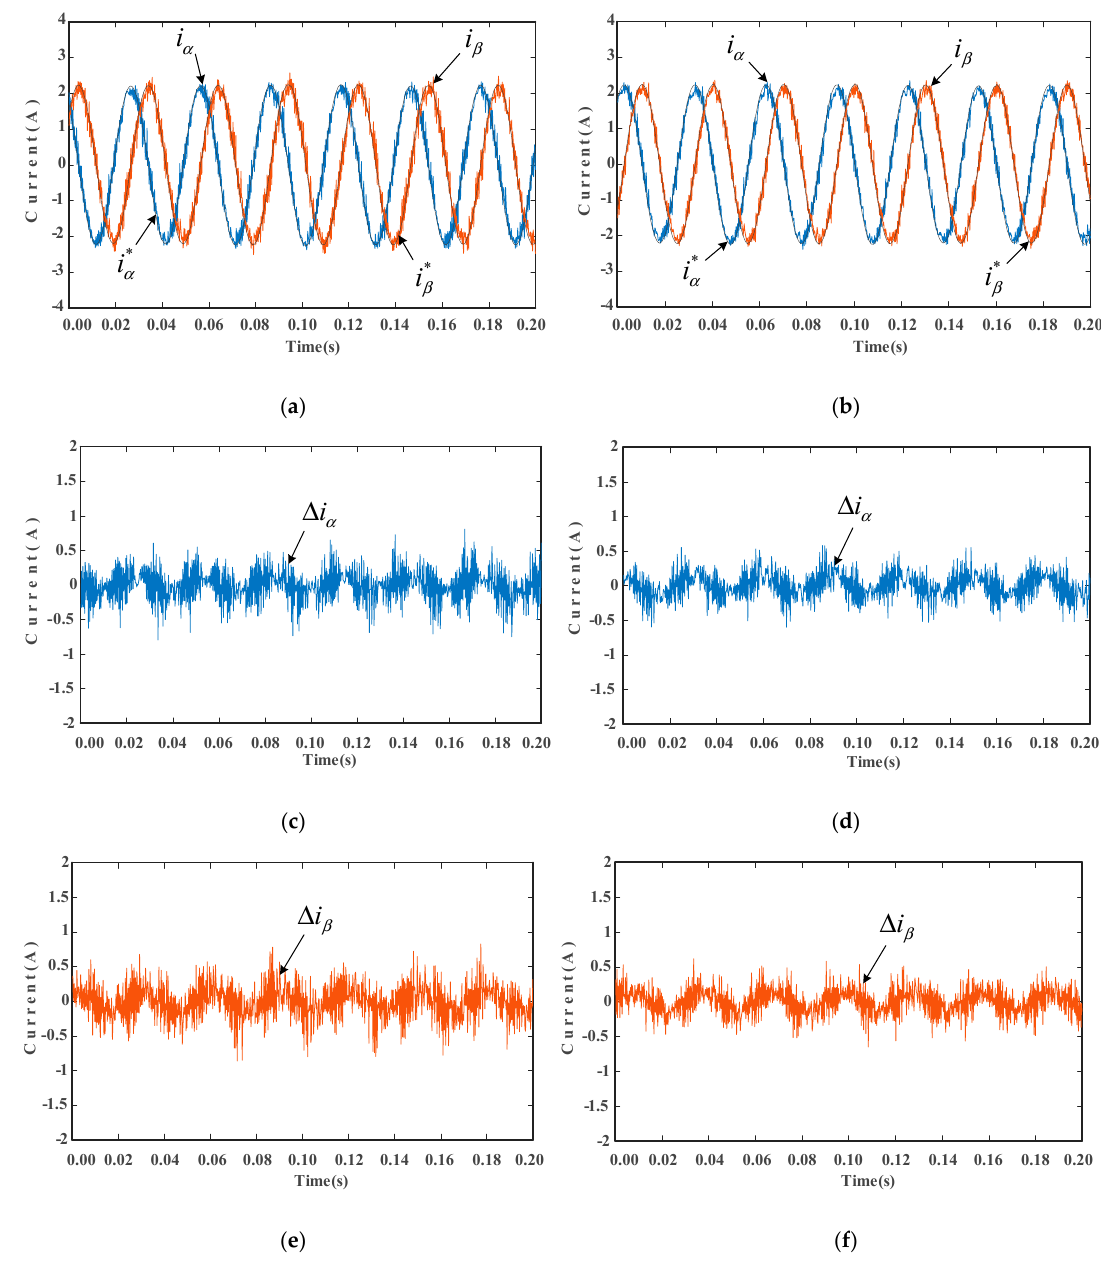
Figure 14. Currents and current errors under constant speed 1000 rpm and load-torque 1 N-m: ( a ) current responses of the MPCC without modulation, ( b ) current responses of the proposed MMPCC, ( c ) the α -axis current error of Figure 14a, ( d ) the α -axis current error of Figure 14b, ( e ) the β -axis current error of Figure 14a, and ( f ) the β -axis current error of Figure 14b.